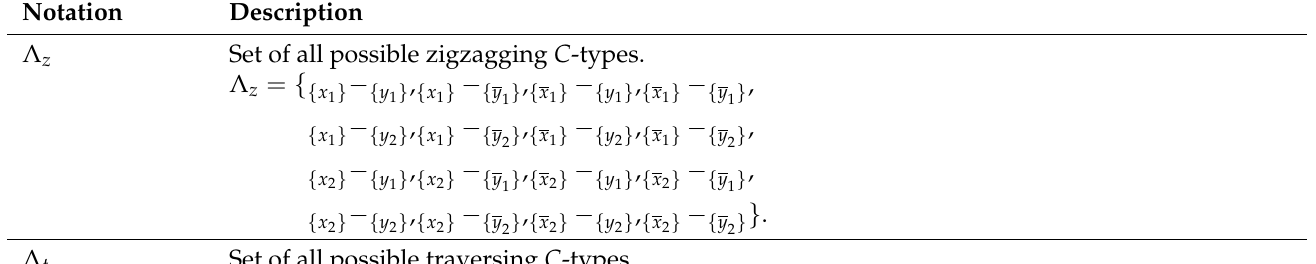
Table A1. Glossary of frequently used